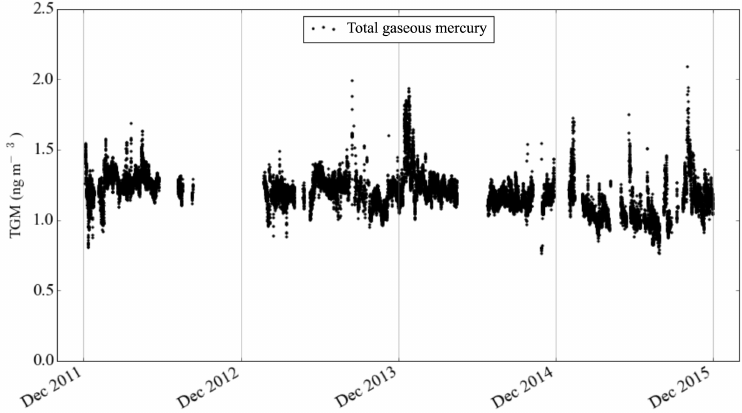
Figure 2. Time series (December 2011–December 2015) of TGM data measured at the Cape Verde